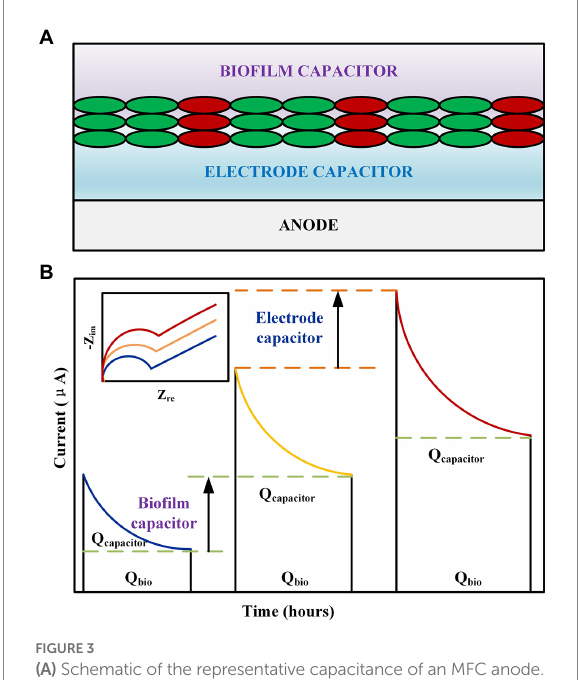
FIGURE 3 (A) Schematic of the representative capacitance of an MFC anode. (B) Effect of MFC electrode capacitance and biocapacitance on the discharge process. Inset: Nyquist diagram corresponding to the MFC electrode capacitance and